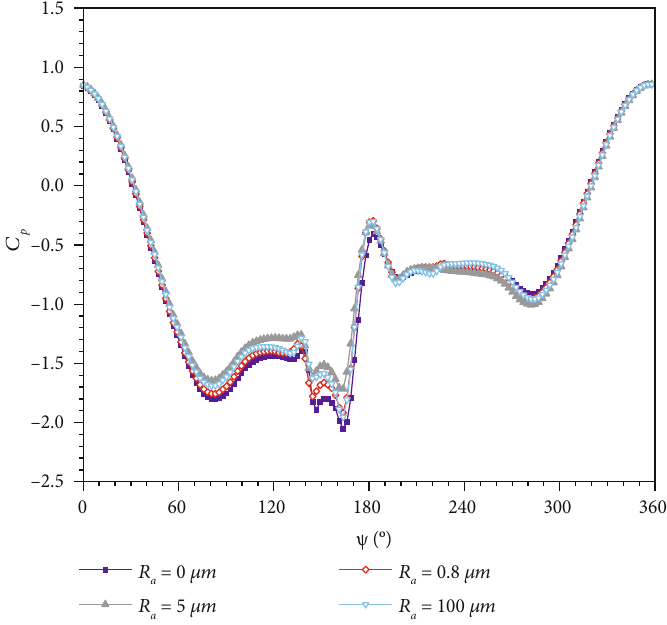
Figure 35: Pressure coe ffi cient distribution of di ff erent models at 2 D .